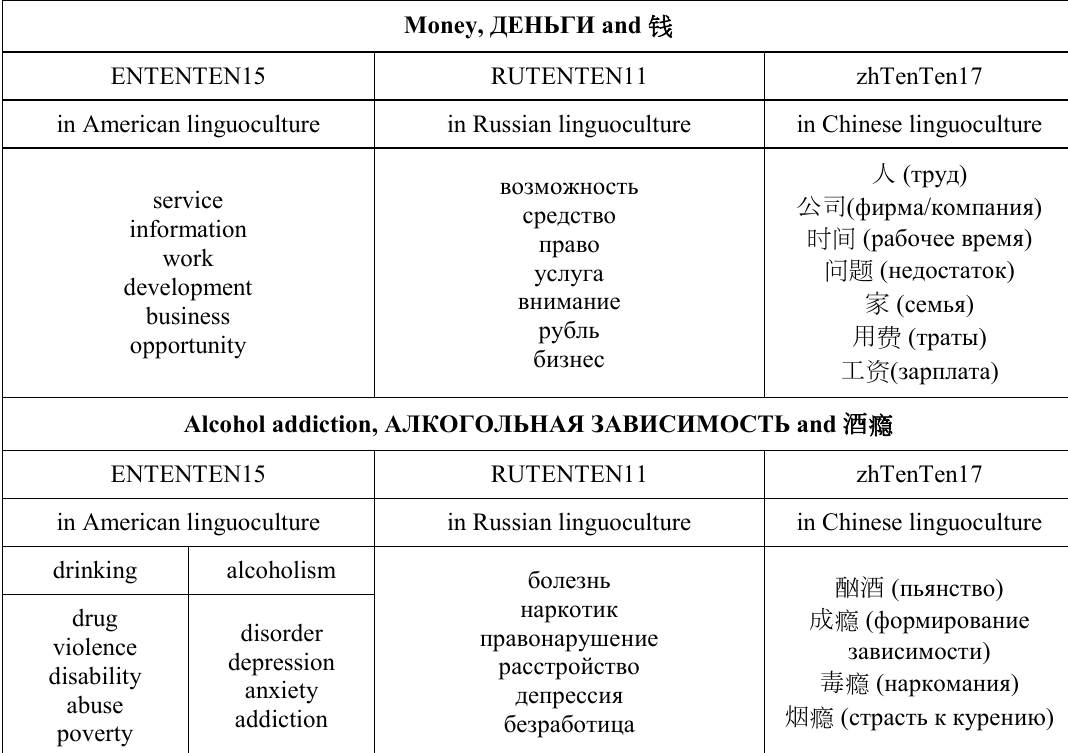
Table 1 – National-cultural specificity of the concepts Money, ДЕНЬГИ and 钱 , Alcohol addiction, АЛКОГОЛЬНАЯ ЗАВИСИМОСТЬ and 酒 瘾 (according to Sketch Engine)